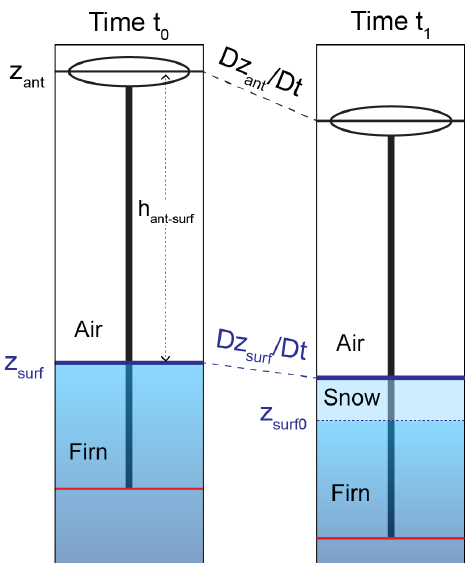
Figure 4. Schematic of GPS station geometry. Surface elevation ( z surf , dark blue line) is computed by removing antenna–surface distance ( h ant − surf , dotted black line) from antenna elevation ( z ant , black line). Pole-base elevation (red line) is computed from pole length and antenna phase-center offset. At time t 1 (right panel), on- going firn compaction resulted in decreased antenna and pole-base elevation, while new snow accumulation offset surface lowering. The layer within the firn column corresponding to the initial surface ( z surf0 ) is represented by dotted blue